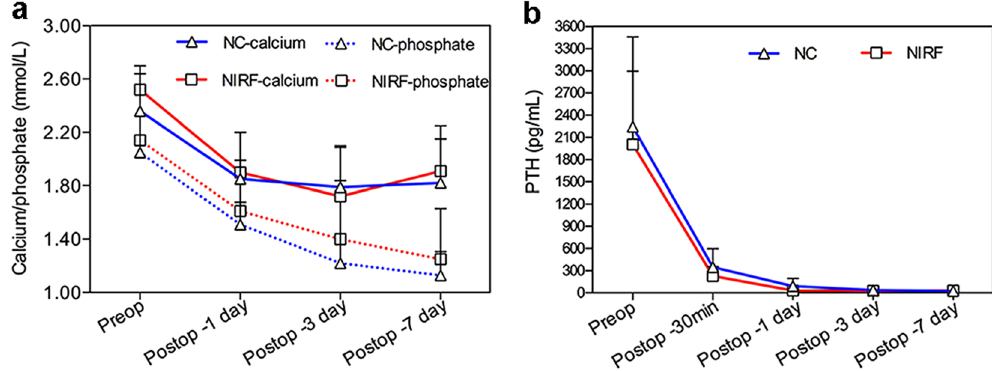
Figure 7. ( a ) The variations of preoperative and the 1 st , 3 rd , 7 th days postoperative serum calcium and phosphorus. ( b ) The variations of preoperative and the 1 st , 3 rd , 7 th days postoperative PTH. Negative control (NC): patients without intraoperative NIRF imaging using